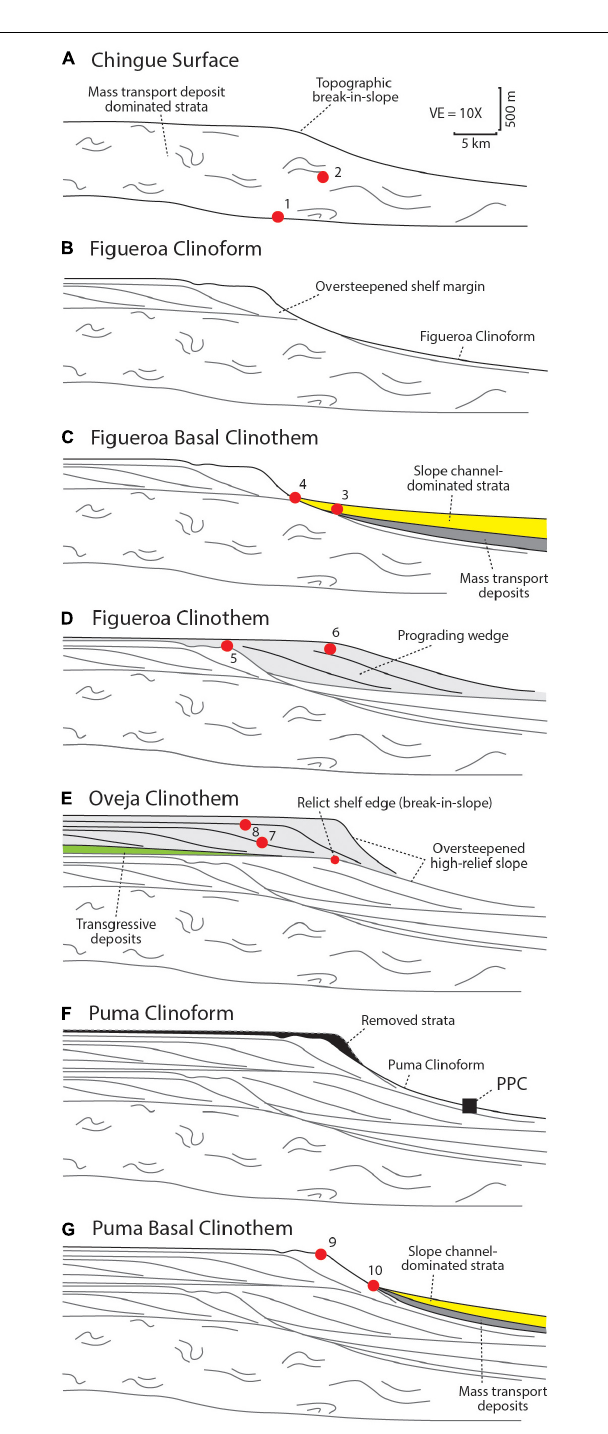
FIGURE 8 | Simplified depositional evolution of shelf-margin strata in the Magallanes Basin study area (from Figure 4 ). Part (A) is the first evolutionary stage through to part (G) , which is the last. Although at this scale clinoforms can only be drawn in a way that implies fairly straightforward correlation of simple surfaces over tens of kilometers, the results of detailed sedimentological and stratigraphic architecture analysis indicate that these surfaces are typically composite features that formed over a protracted period